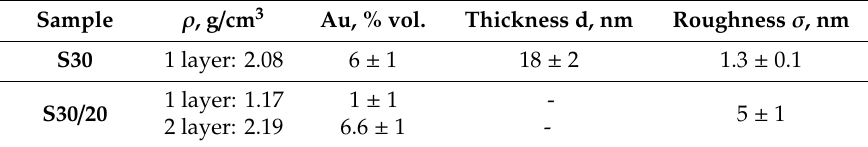
Table 2. Parameters of the samples measured with XRR.